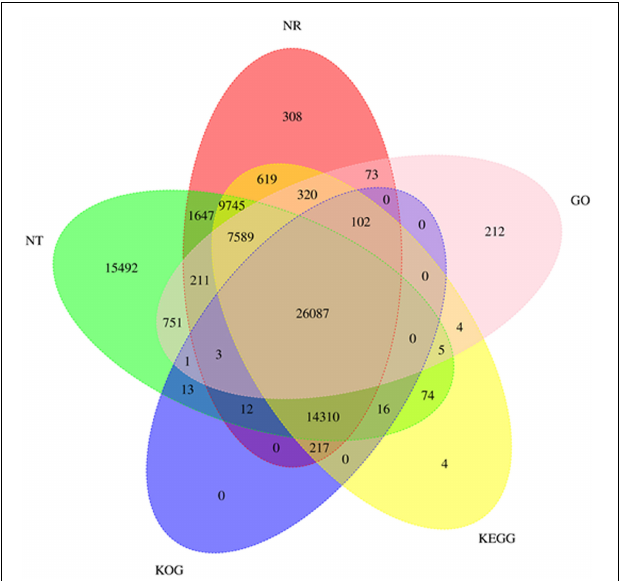
FIGURE 2 | Venn diagram of the functional annotation of the long-read transcriptomes in Nr, Nt, GO, KOG, and KEGG databases. Nr , non-redundant protein database; Nt , non-redundant nucleotide sequences; GO , Gene Ontology; KOG , Clusters of Orthologous Eukaryotic Genes; KEGG , Kyoto Encyclopedia of Genes and Genomes.